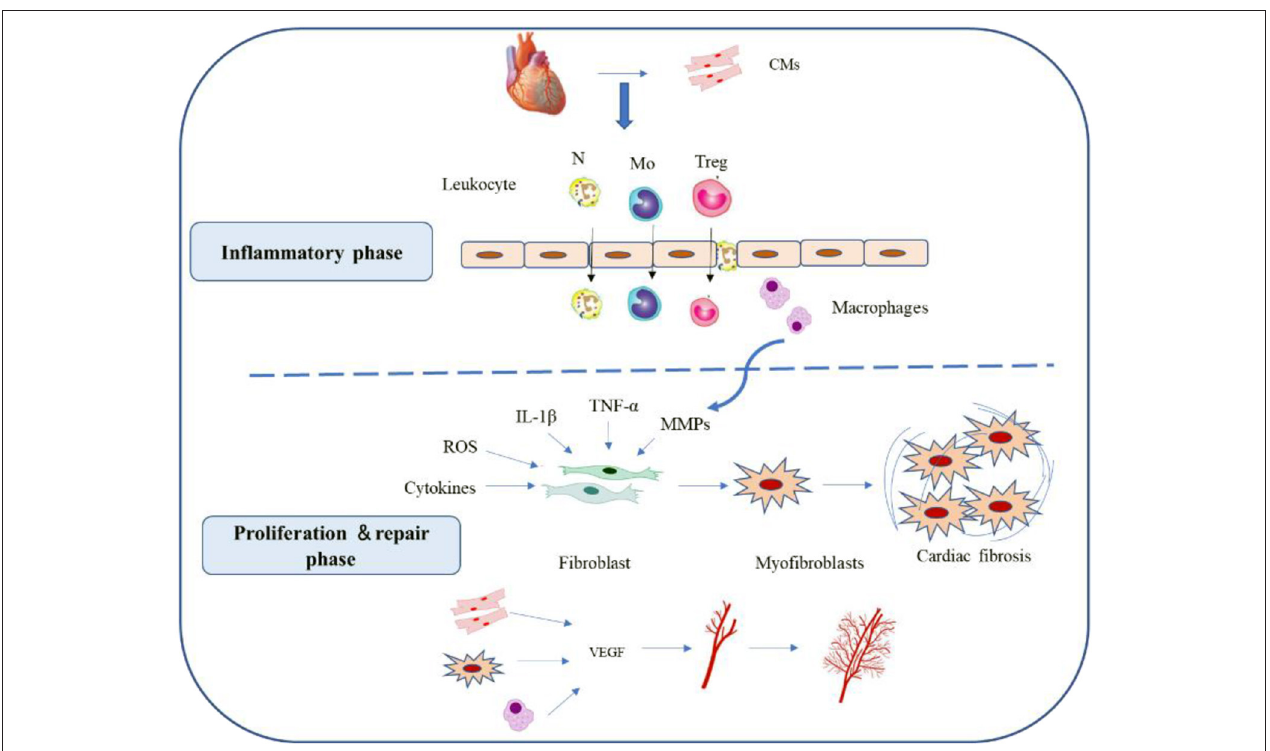
FIGURE 1 | Reparative response following a myocardial infarction. Cardiac repair after MI results from a finely orchestrated and complex series of events, initiated by intense sterile inflammation, and immune cell infiltration (inflammatory phase) that serve to digest and clear damaged cells and extracellular matrix tissue, followed by a proliferation and repair phase with resolution of inflammation, (myo)fibroblast proliferation, scar formation, and angiogenesis over the next several days. CMs, cardiomyocytes; N, neutrophil; MO, monocytes; Treg, Regulatory cells; ROS, reactive oxygen species; VEGF, vascular endothelial growth factor.